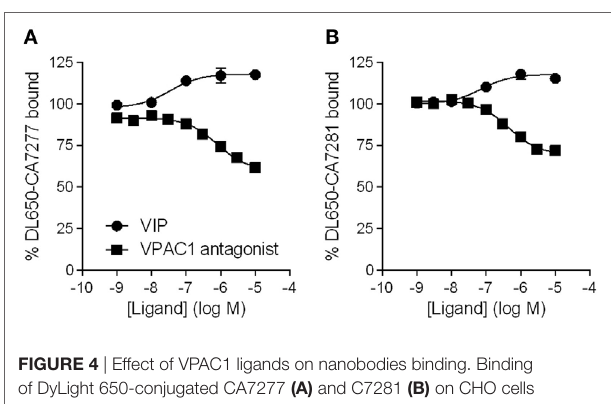
FigUre 4 | Effect of VPAC1 ligands on nanobodies binding. Binding of DyLight 650-conjugated CA7277 (a) and C7281 (B) on CHO cells expressing VPAC1 in presence of increasing concentrations of VIP (filled circles) or VPAC1 antagonist (filled squares). The results are the means ± SEM of three independent experiments performed in